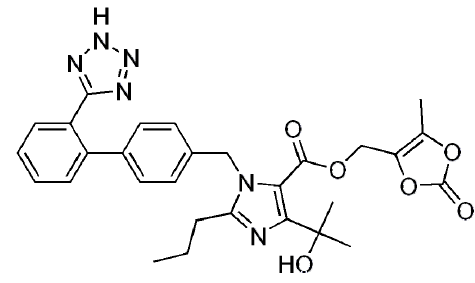
Figure 1. Chemical Structure of Olmesartan Medoxomil.